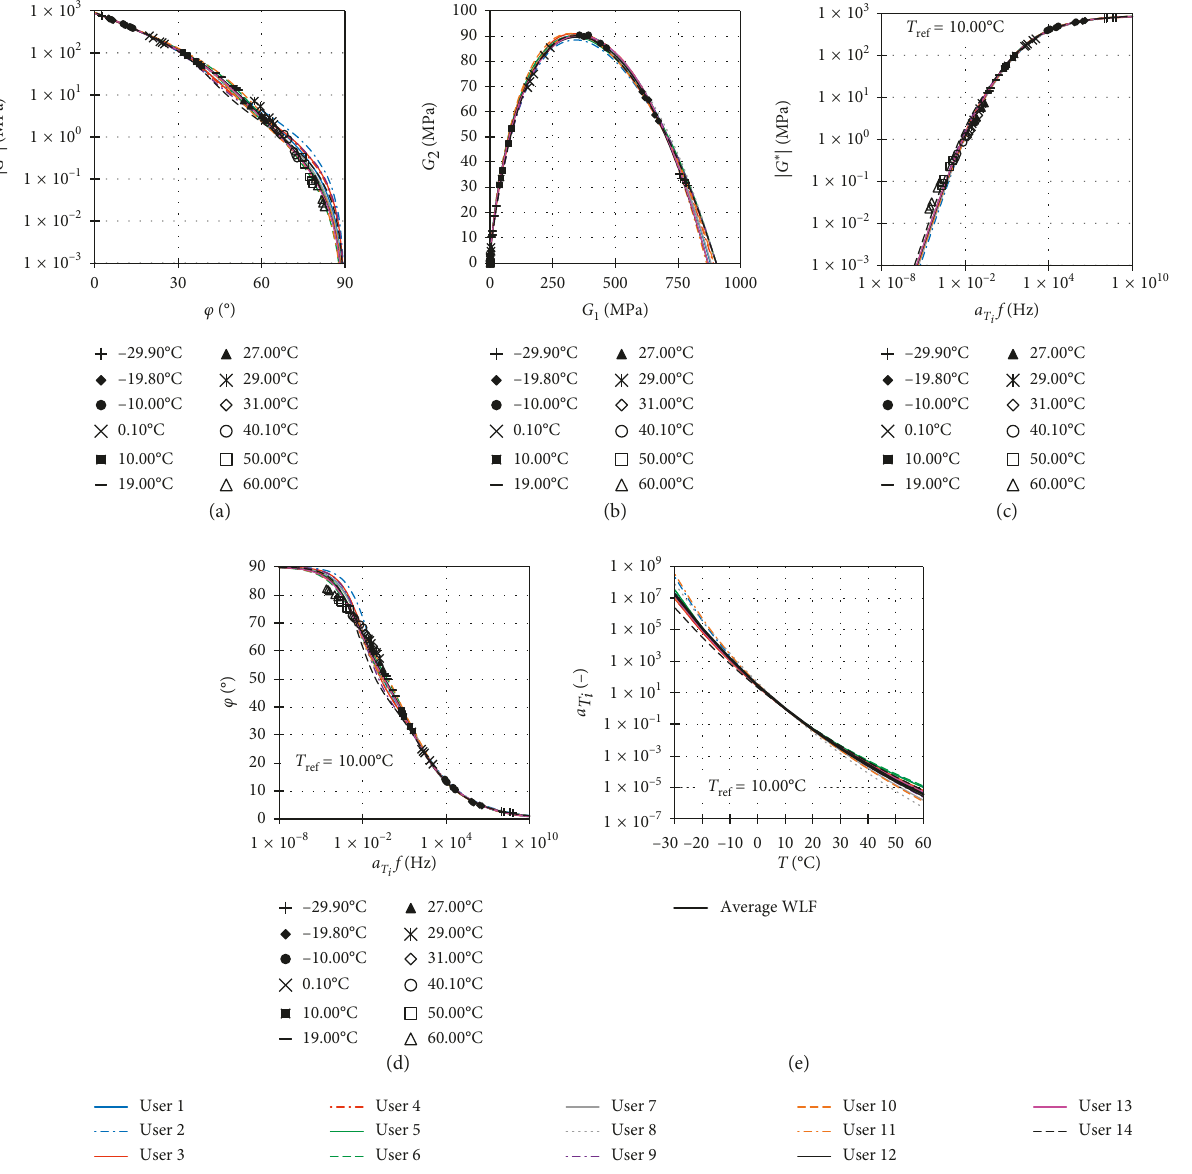
Figure 4: Results of 2S2P1D calibration panel for the bitumen: (a) Black space; (b) Cole-Cole plan; (c) master curves of master curves of φ at 10.00 ° C; (e) WLF equation used by users to obtain master curves in (c and d) and average WLF